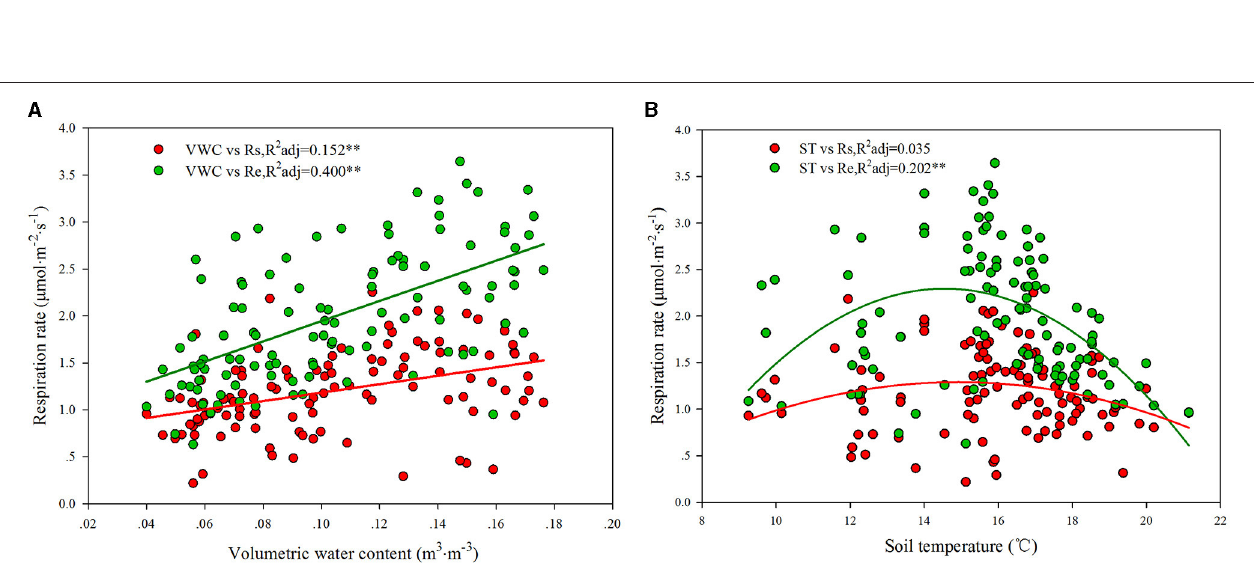
FIGURE 7 | Relationships between volumetric water content (VWC), Rs and Re (A) ; Relationships between ST and Rs and Re (B) . ** p < 0.01.